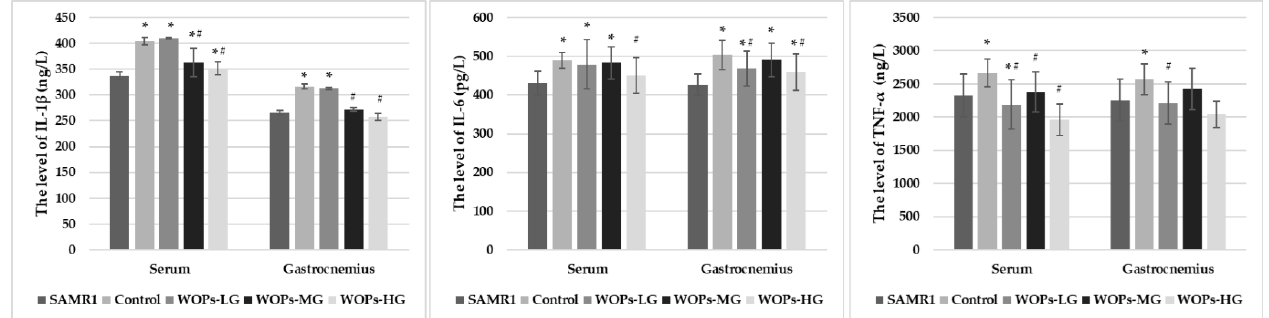
Figure 2. Effects of WOPs on the proinflammatory factors in serum and gastrocnemius. Data is expressed as mean ± SD ( n = 13–15 per group). p values were assessed using ANOVA-test. * p < 0.05 vs. SAMR1 and # p < 0.05 vs. Control. SAMR1, SAMR1 model control group; Control, SAMP8 age control group; WOPs-LG, SAMP8-WOPs-LG at a dose of 110 mg/kg·bw; WOPs-MG, SAMP8-WOPs-MG at a dose of 220 mg/kg·bw; WOPs-HG, SAMP8-WOPs-HG at a dose of 440 mg/kg·bw.